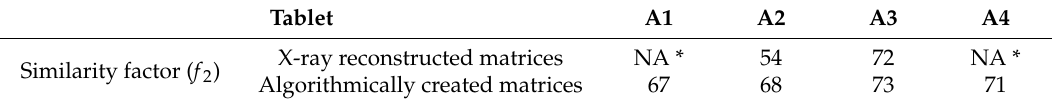
Table 6. Summary of similarity factors ( f 2 ) between in vitro and in silico drug release